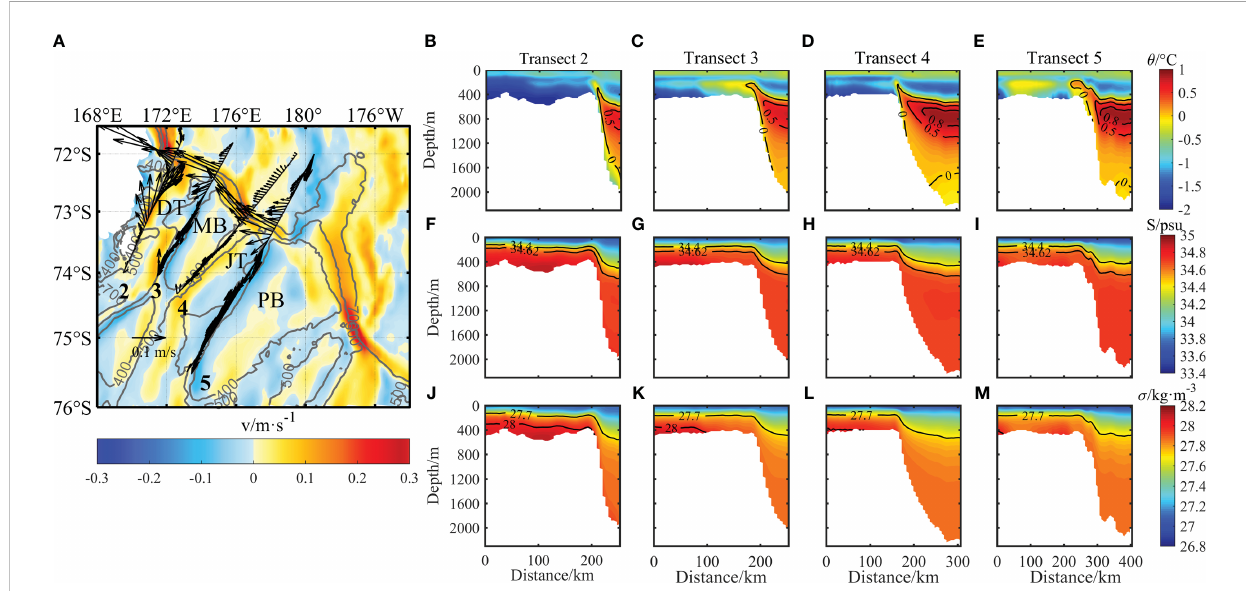
FIGURE 4 (A) Climatological February depth-transect averaged currents (vectors) along Transects 2 – 5 in Figure 1, south – north components (blue, southward; red, northward), and the isobaths (gray lines). (B – E) Potential temperature q , (F – I) salinity S, and (J – M) potential density anomaly s along Transects 2 – 5. The black lines indicate the isotherms, isohalines, or